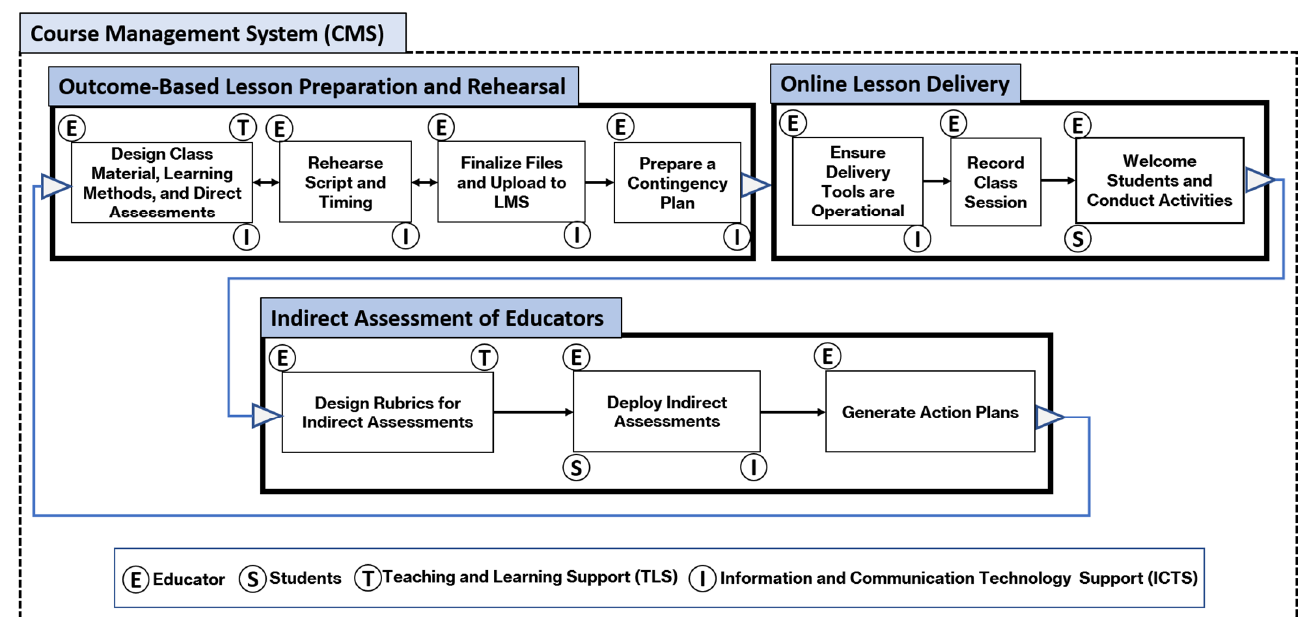
Figure 2. The Course Management System (CMS) constituent of the QA framework.